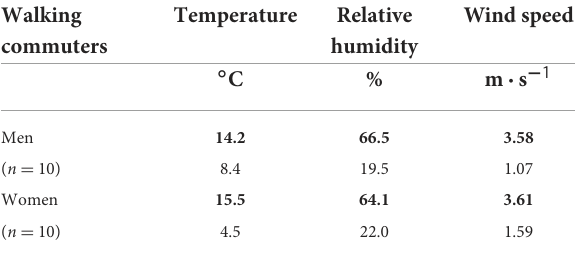
TABLE 2 Ambient conditions in walking commuting (mean and